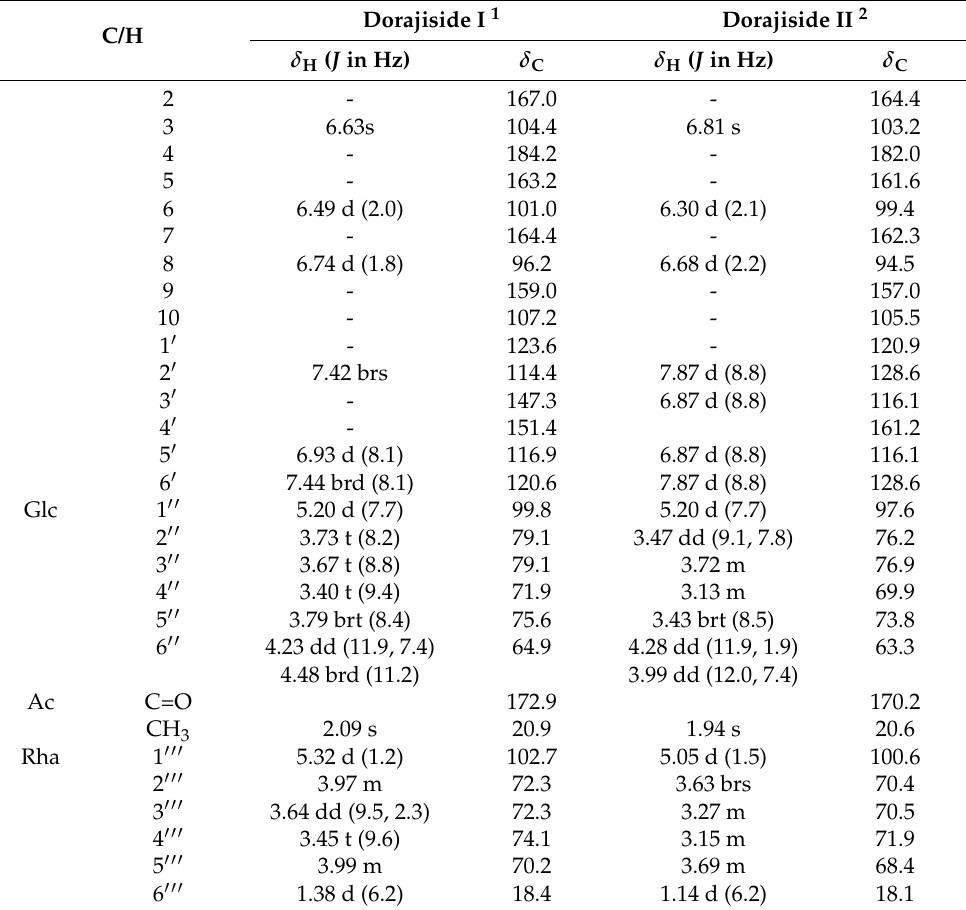
Table 2. 1 H and 13 C NMR data of compounds 1 and 2